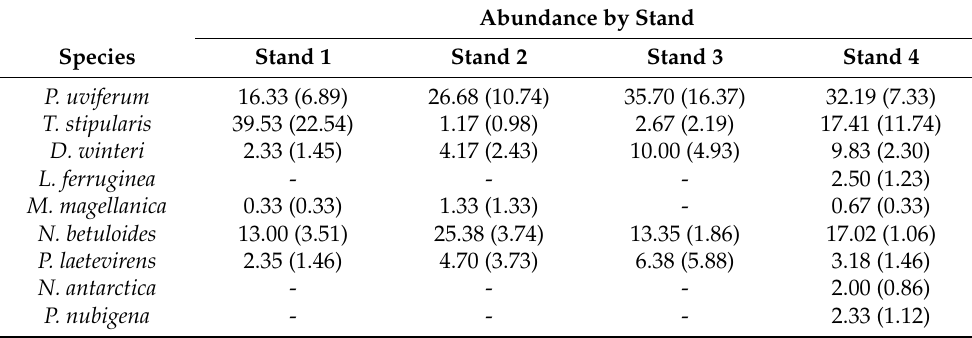
Table 4. Abundance of species in each stand in Kaw é sqar National Park. The values are the means and standard error (in brackets) per stand.